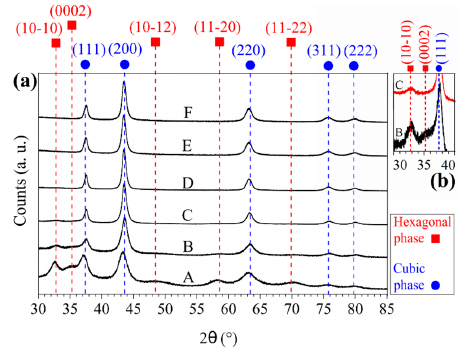
Figure 7. X-ray diffractograms showing ( a ) the phase content as a function coil current. ( b ) The presence of both B1 (cubic) and B4 (wurtzite) phases for coatings B and C. Cross-sectional and plan view TEM micrographs including selective area electron diffraction (SAED) patterns of coatings A, C, and F are shown in Figure 8. All coatings display diffuse contrast,